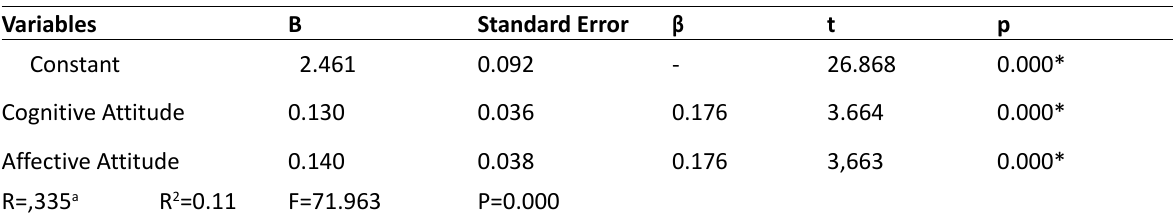
Table 4. Results of multiple regression analysis of attitude to physical education course in predicting school commitment